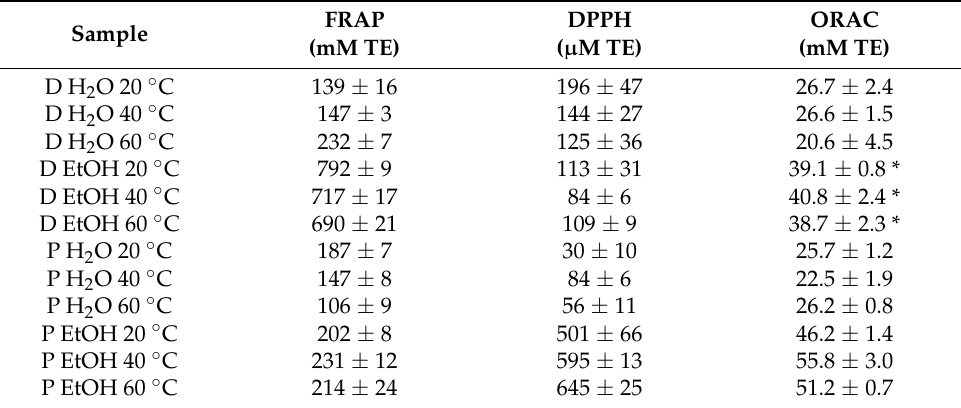
Table 2. Antioxidant activity of Dictyota dichotoma (D) and Padina pavonica (P) extracts detected by the FRAP, DPPH and ORAC